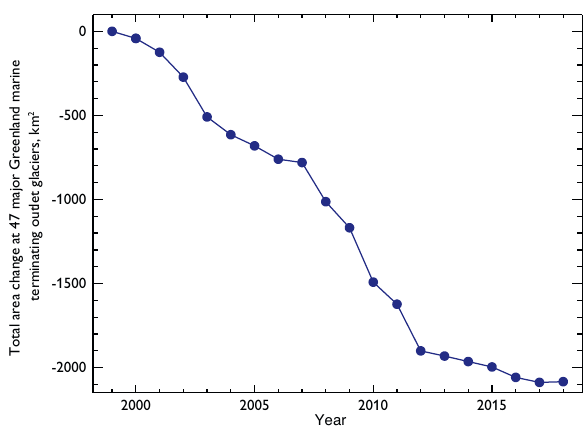
Fig. 4: Cumulative net area change for 47 Greenland marine terminating outlet glaciers during the period 1999–2018. Area changes were generated from the PROMICE calving front line product (https://doi.10.22008/